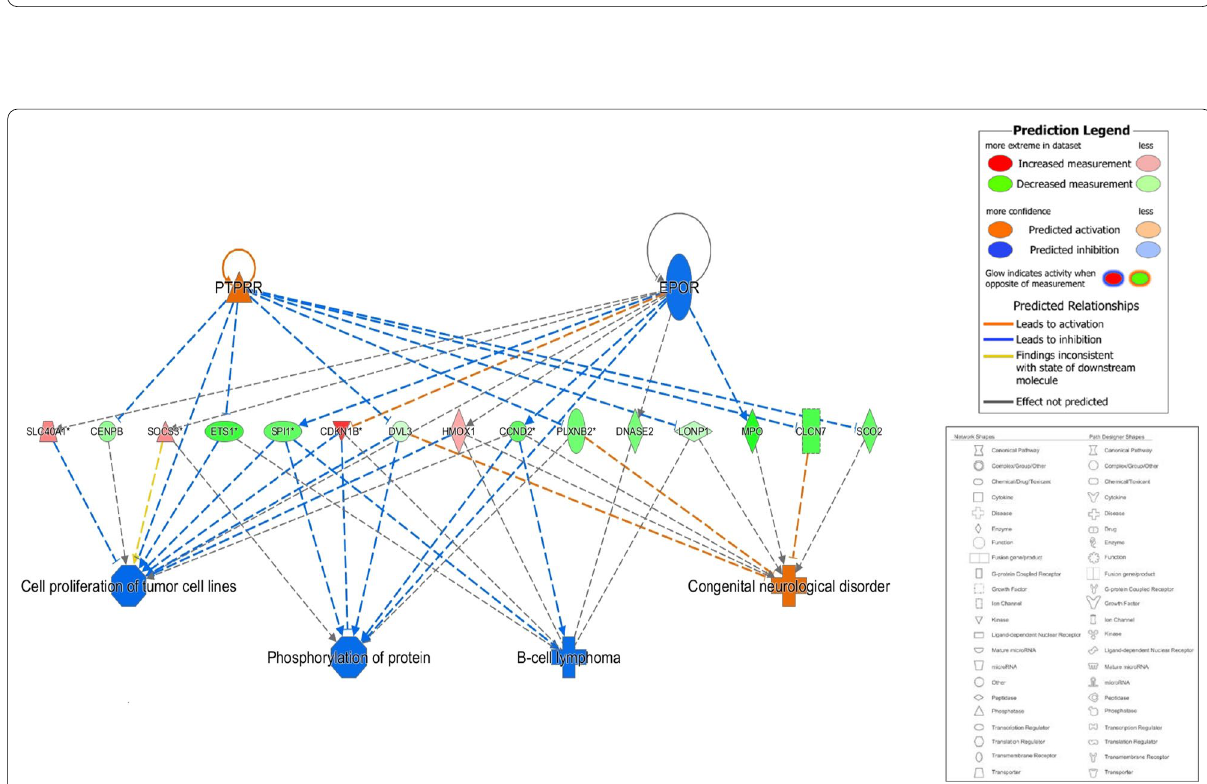
Fig. 2 Upstream regulators ( A ) filgrastim and ( B ) ESR1. Chemical drug filgrastim is predicted to be activated in sepsis with p -value Z-score 4.170. (BESR1 is predicted to be activated in sepsis with P -value class of the protein. Red and green indicate down-regulation and up-regulation, respectively, while blue and orange indicate inhibition and activation, respectively. A solid line indicates a direct interaction, a dashed line indicates an indirect interaction, and a dotted line indicates inferred correlation from machine-based learning. An asterisk indicates that multiple identifiers in the dataset file map to a single gene or chemical in the Global Molecular Network